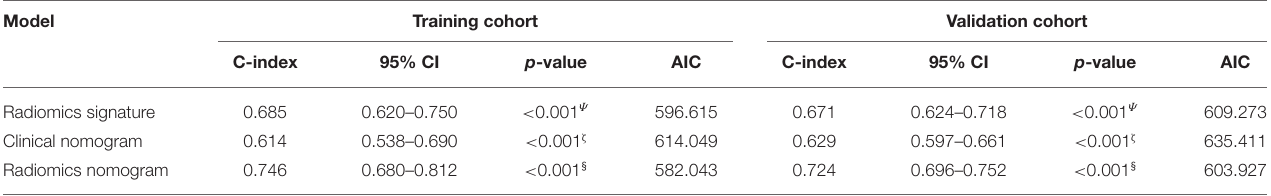
TABLE 2 | Comparison of the discriminating performance of the radiomics signature, clinical nomogram, and radiomics nomogram.